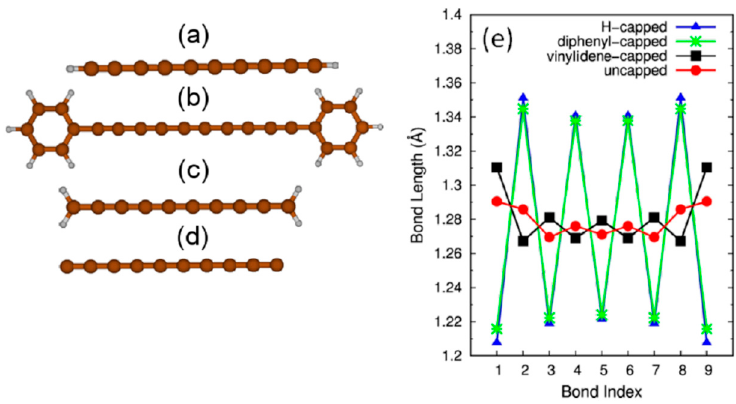
Figure 1. Carbon chains are mostly cumulenic or polyynic, depending on terminating molecules: ( a – d ) Carbon-atom wires with different terminations: Hydrogen-capped (a), phenyl-capped (b), vinylidene-capped (c), and uncapped (d). ( e ) The bond length as a function of the number of carbon atoms comprising the wire. Reproduced with permission from [7].